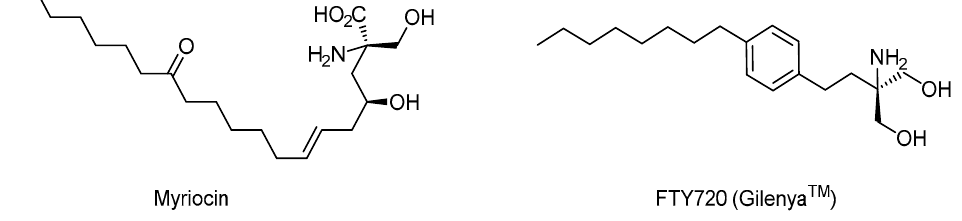
Figure 6. Structures of Myriocin (left) and FTY720 (right).